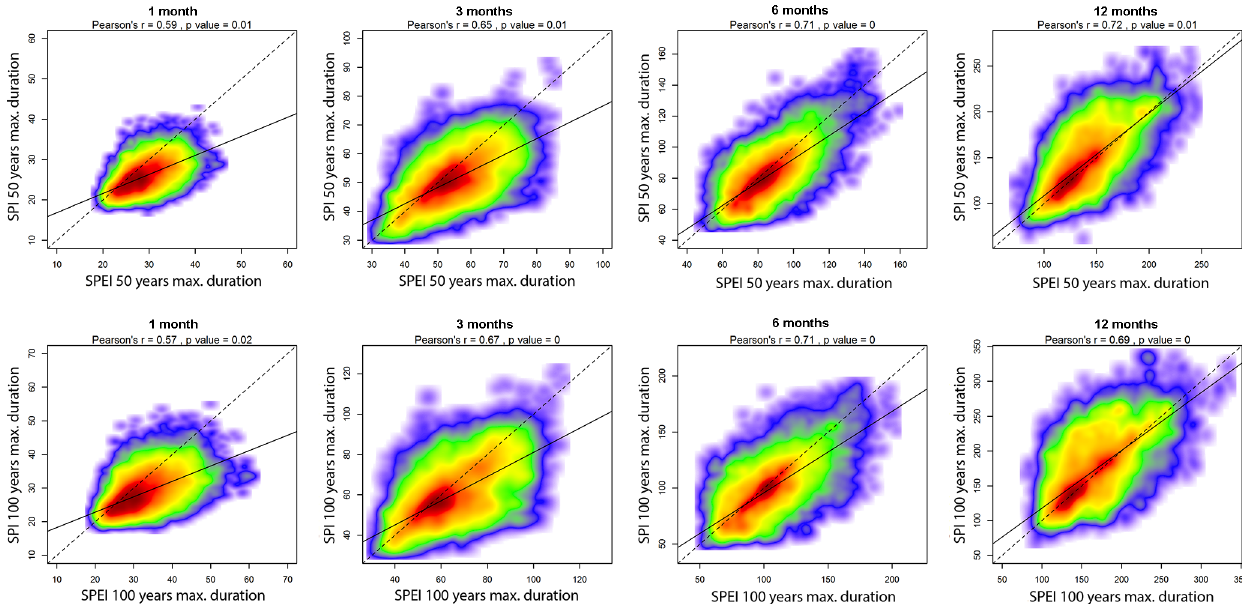
Figure 11. Scatterplots showing the relationship between the maximum drought duration (in weeks) expected in a period of 50 and 100 years considering 1-, 3-, 6-, and 12-month SPEI and the SPI. The colours represent the density of points, with red denoting the highest density. Given the large sample used, the significance of the Pearson’s r coefficients was estimated by means of a Monte Carlo approach using 10 3 random samples, with each sample containing 30